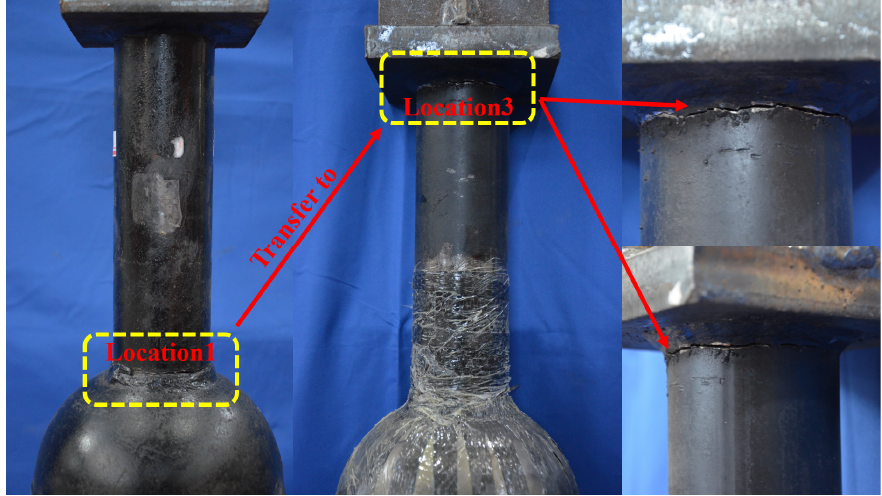
Figure 13. Failure mode 2.